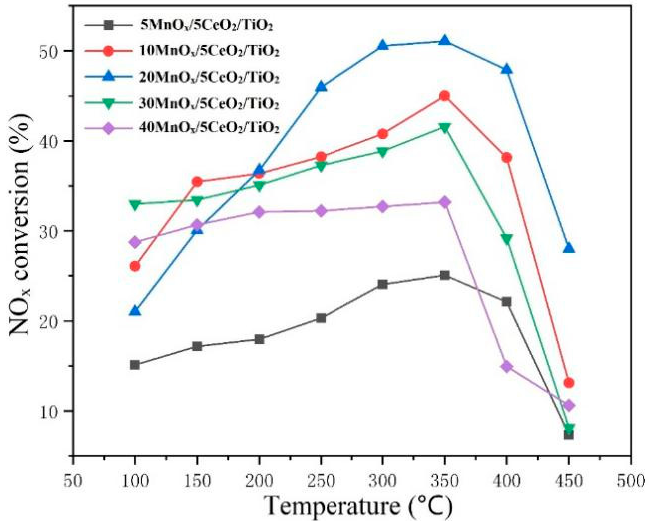
Figure 7. Nitrogen oxides (NO x ) conversion of different MnO x /CeO 2 /TiO 2 coatings.